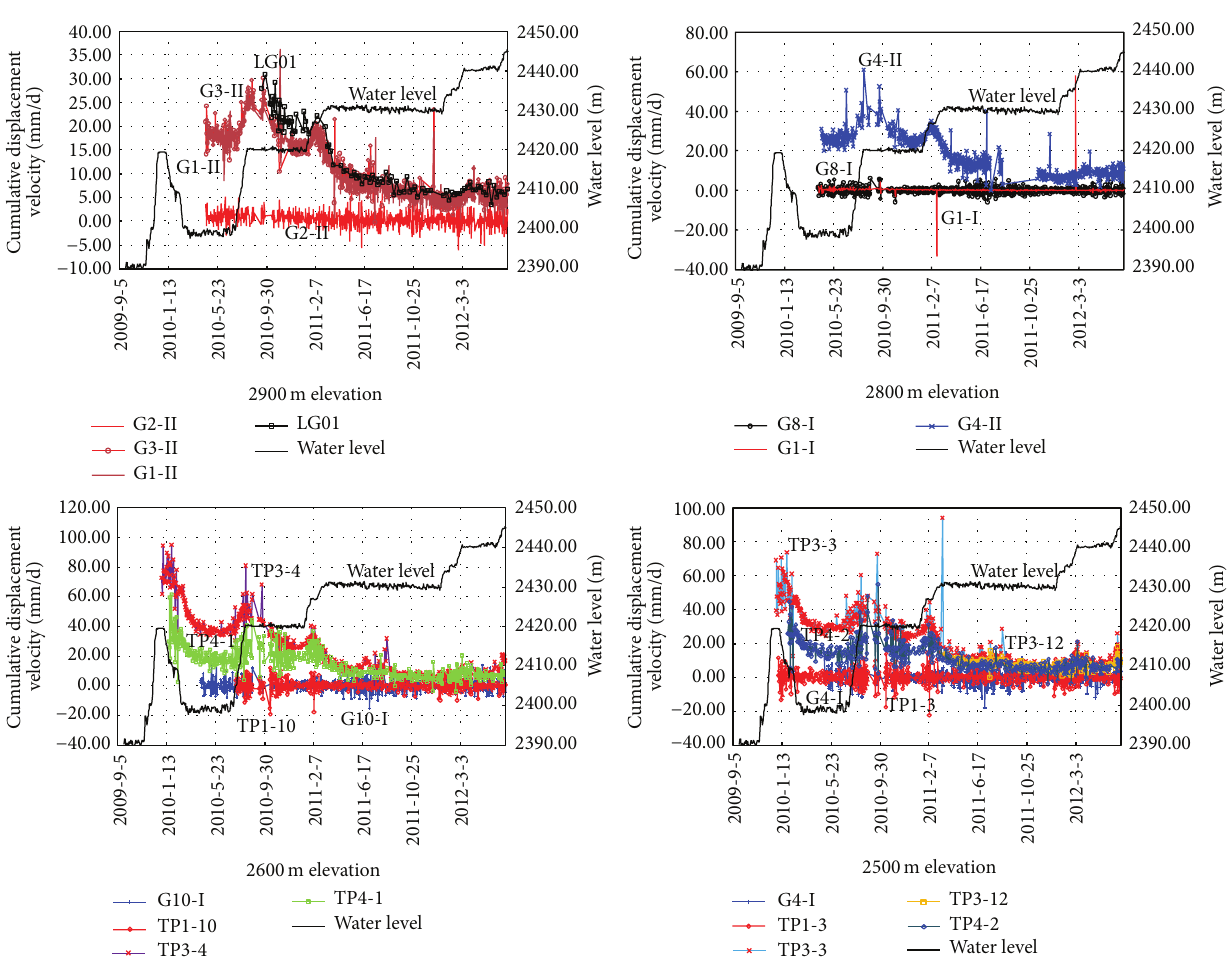
Figure 3: Points monitored from downstream to upstream of the slope for different elevations.